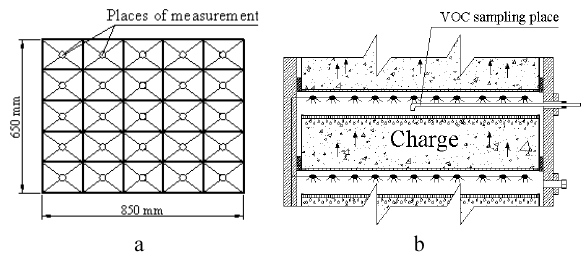
Fig. 3. Location of physical air settings and pollutant te- sting: a – places of air-flow velocity and temperature mea- surement; b – place of volatile organic compound sampling